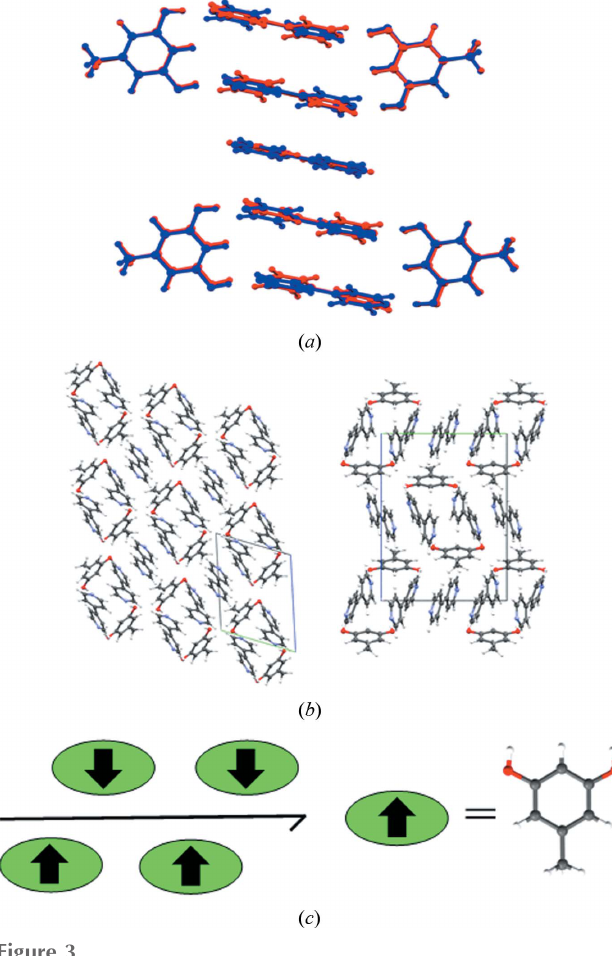
Figure 3 Orcinol–bipyridine: ( a ) overlay diagram of forms II and III ; ( b ) arrangement of LSAMs in form II , right, and form III , left; ( c ) schematic of molecular arrangement along the2 1 -screw axis in form III .